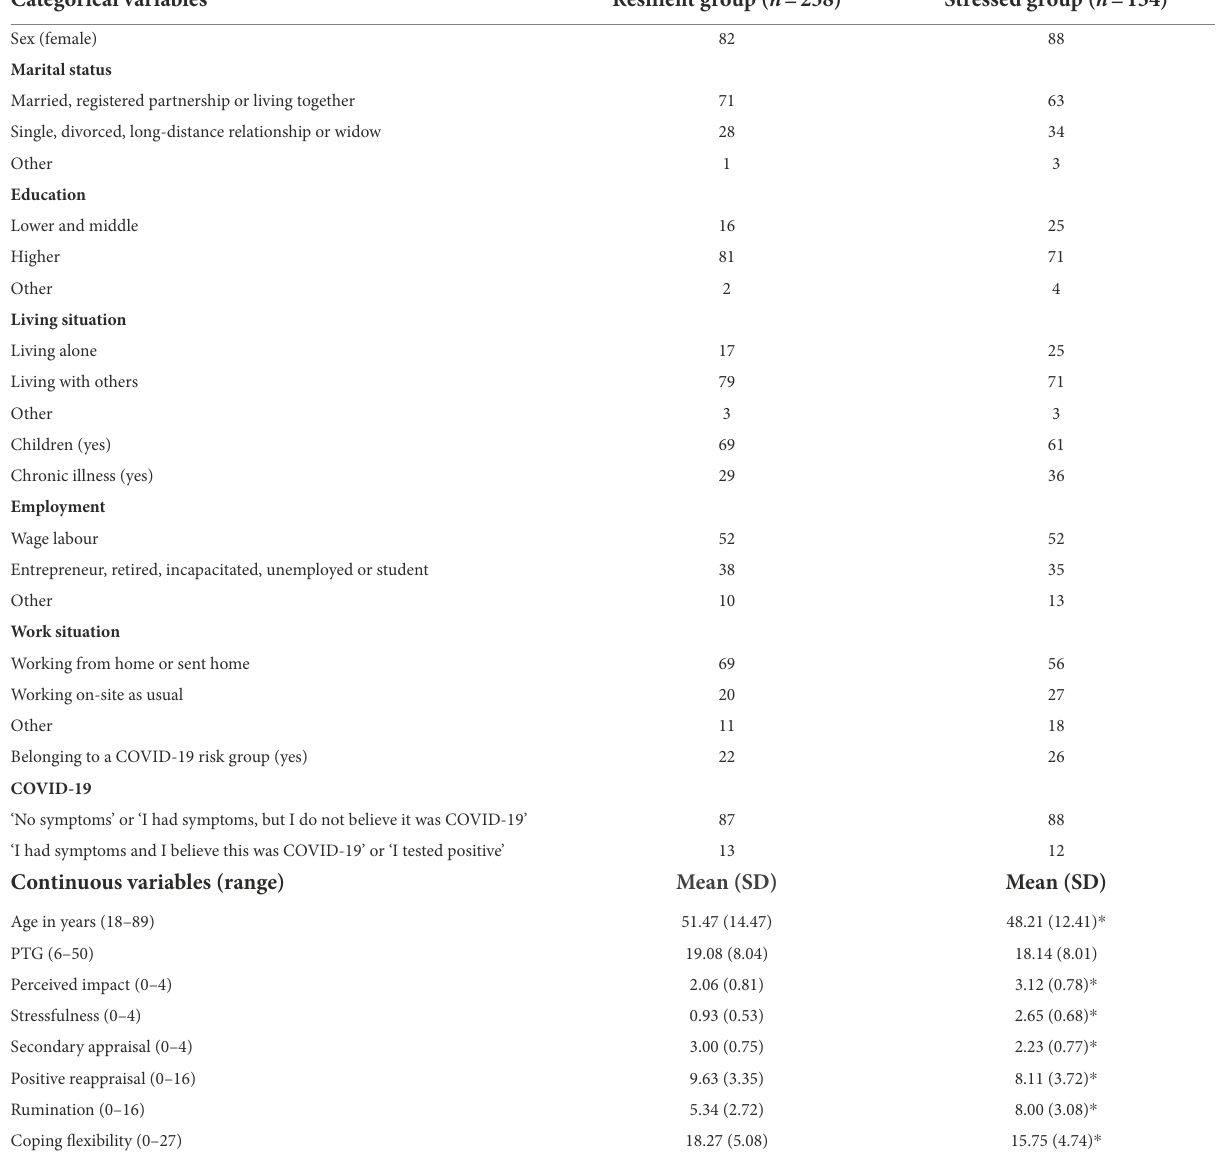
TABLE 4 Profile percentages and means ( SD ) per